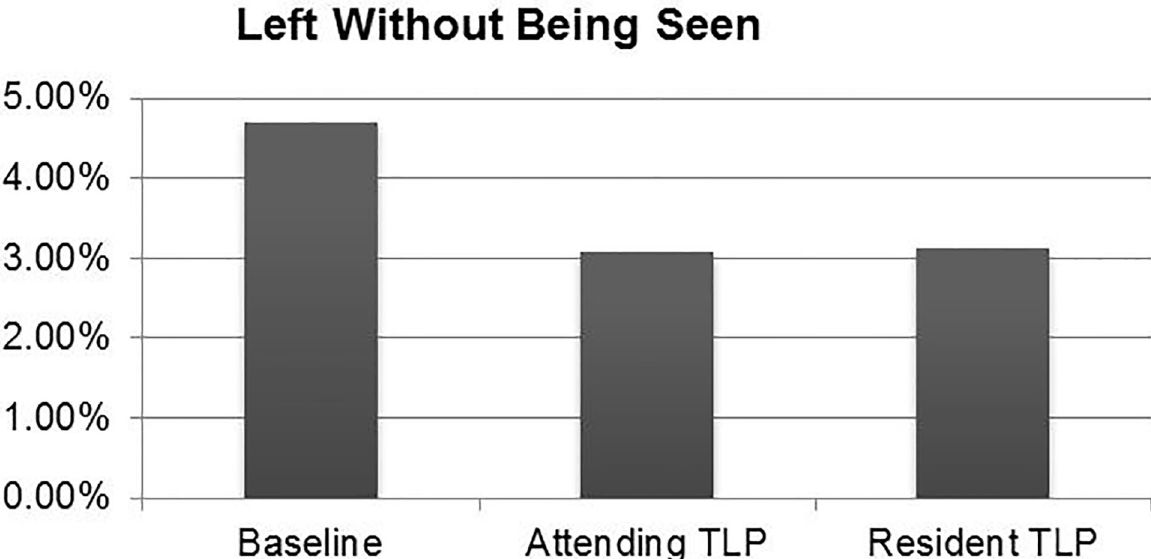
Figure 5. Difference in “left without being seen” percentage between attending TLP, resident TLP, and historical control.